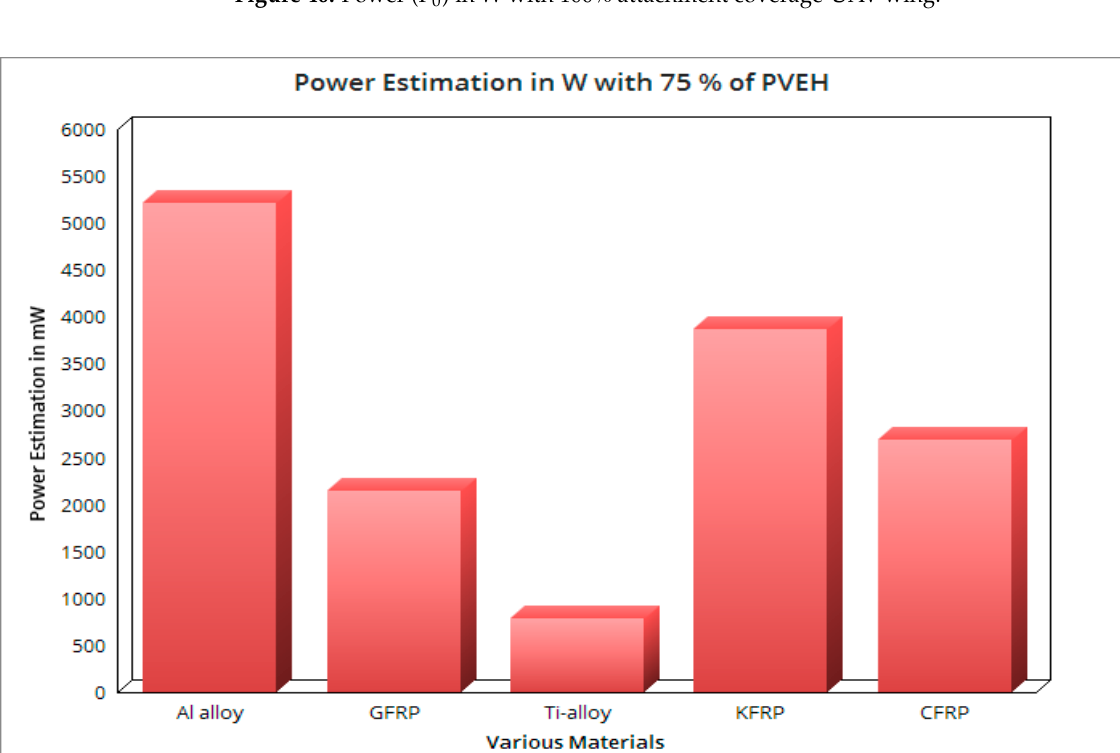
Figure 40. Power (P 0 ) in W with 100% attachment coverage-UAV wing.